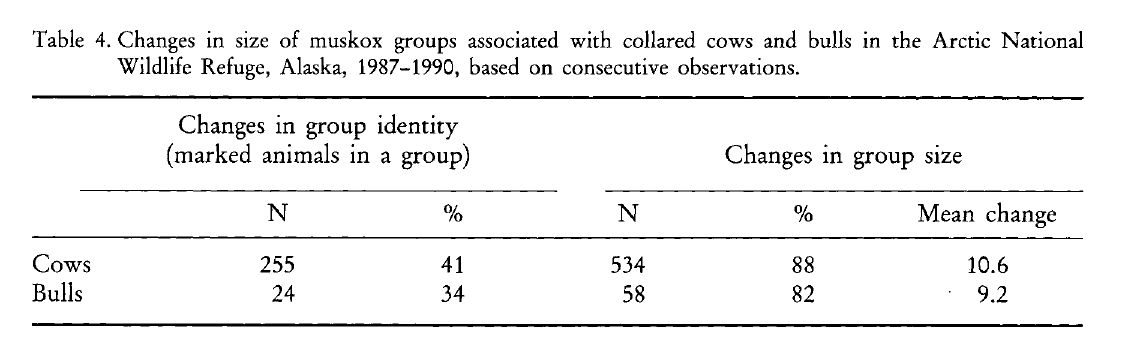
Table 4. Changes in size of muskox groups associated with collared cows and bulls in the Arctic National Wildlife Refuge, Alaska, 1987-1990, based on consecutive observations. Changes in group identity (marked animals in a group)